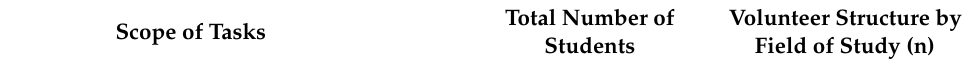
Table 1. Participation of Poznan University of Medical Sciences student volunteers in various units and the scope of the entrusted tasks (as of 19 May 2020).